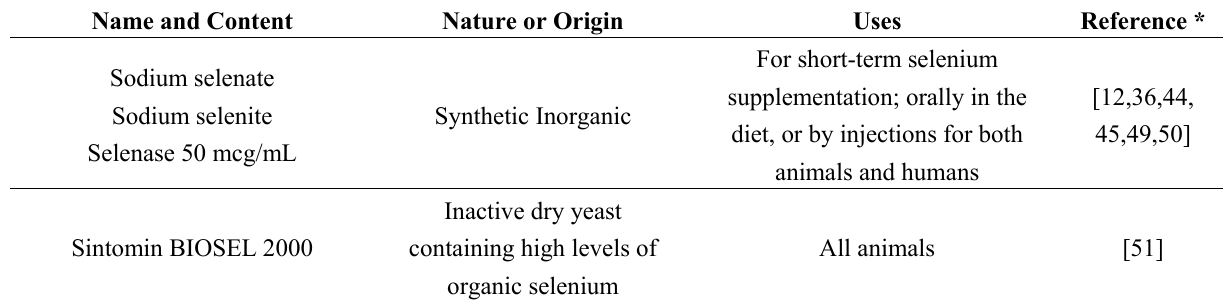
Table 1. Selenium compounds and their application in animal and human